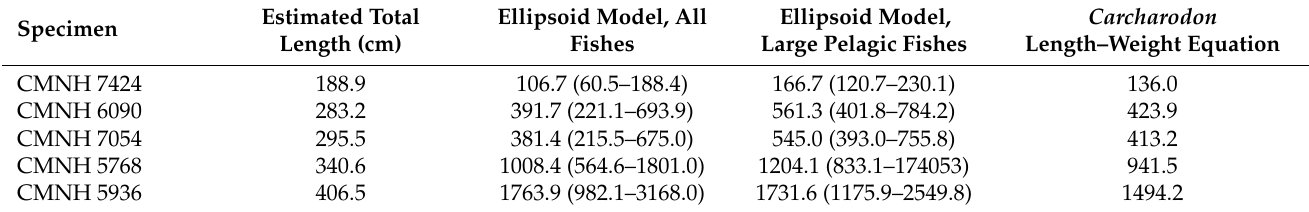
Table 5. Estimated body masses of Dunkleosteus terrelli and their 95% prediction intervals in kg.